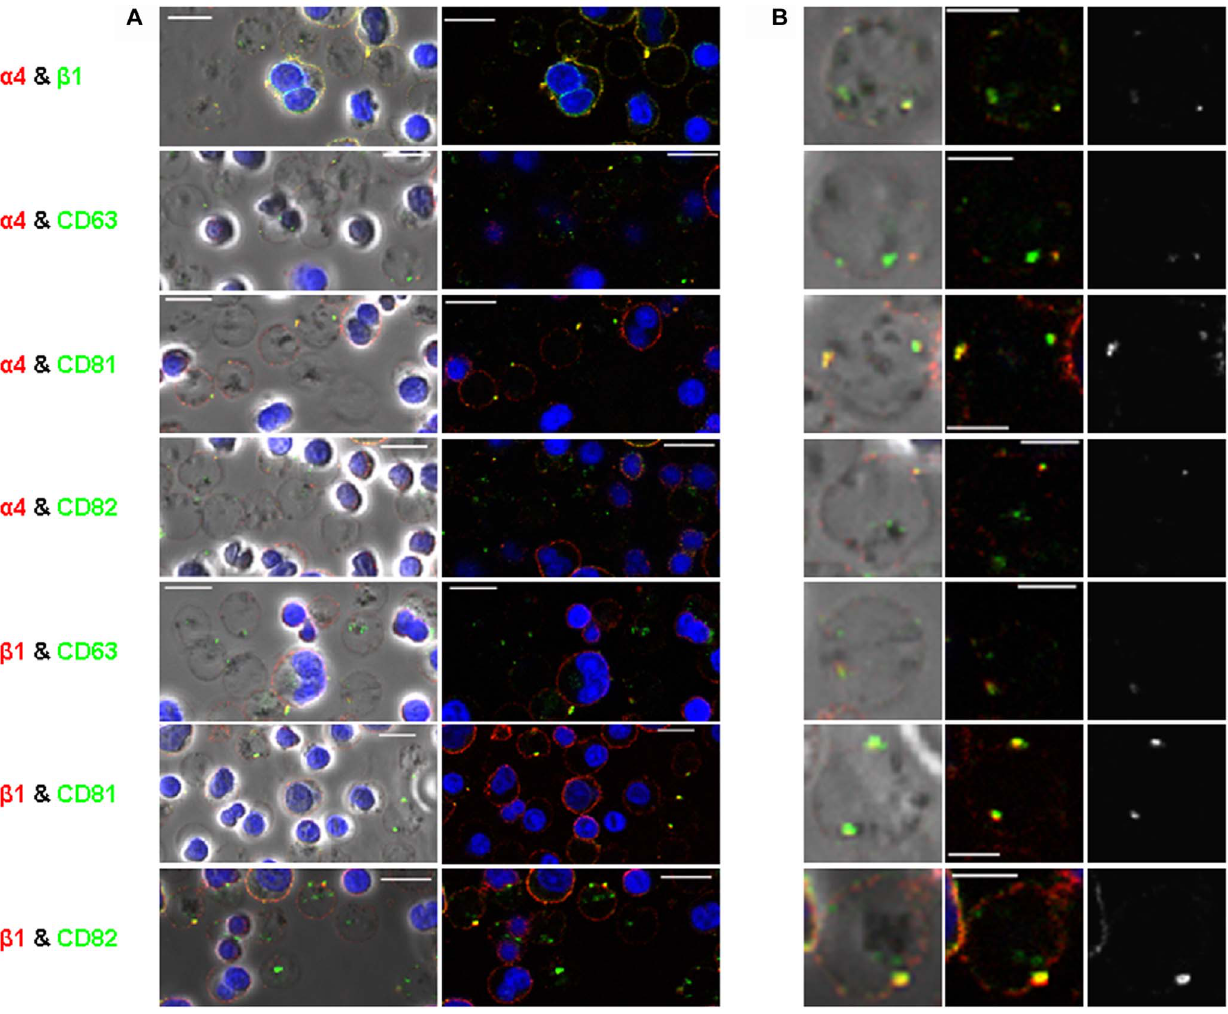
Figure 3. Confocal imaging of reticulocytes. A. (A) Dual staining of tetraspanins CD63, CD81 and CD82 (all green) with a 4 and b 1 integrins (both red) on day 12 of culture shown in phase contrast and fluorescence (scale bars=10 m m). Colocalisation is seen in yellow. (B) Single examples of reticulocytes zoomed in from images in (A) shown in phase contrast, fluorescence and greyscale images. Yellow on phase contrast and fluorescence denotes colocalisation. The righthand grayscale images highlight yellow areas of colocalisation only (scale bars=5 m